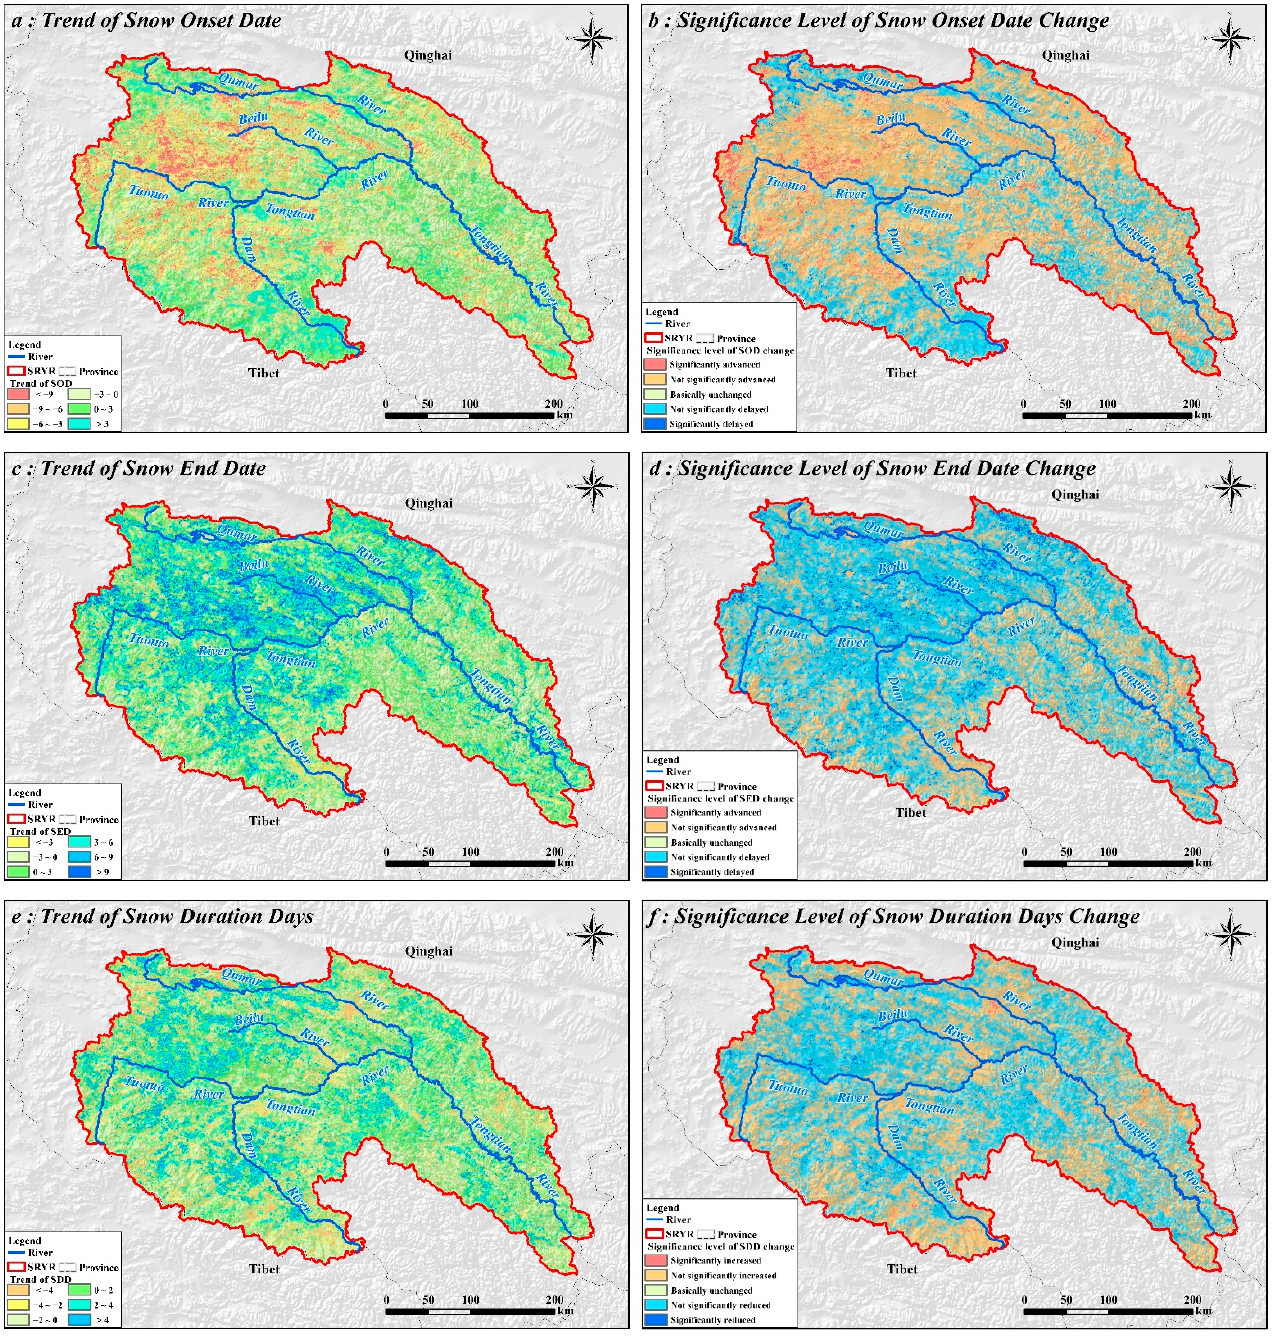
Figure 6. Snow phenology variation trend and significance distribution of SRYR.